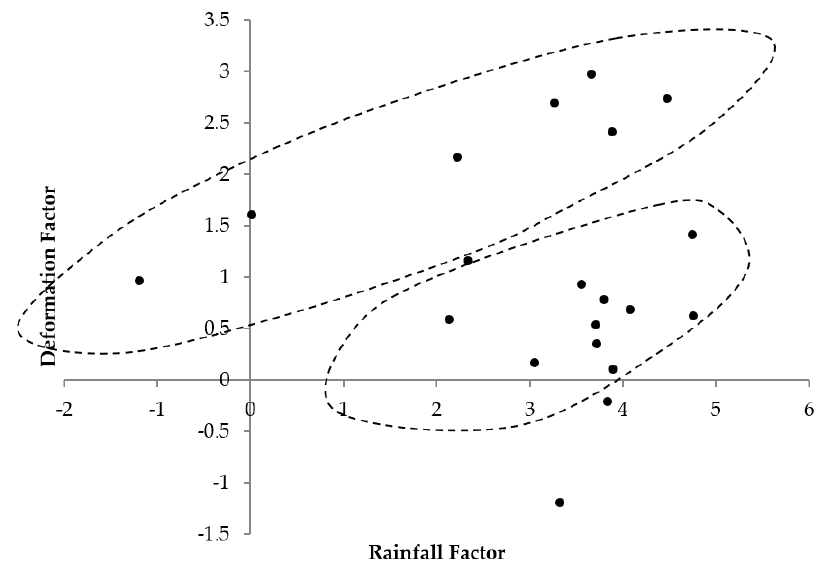
Figure 16. Rainfall factor for model modification.